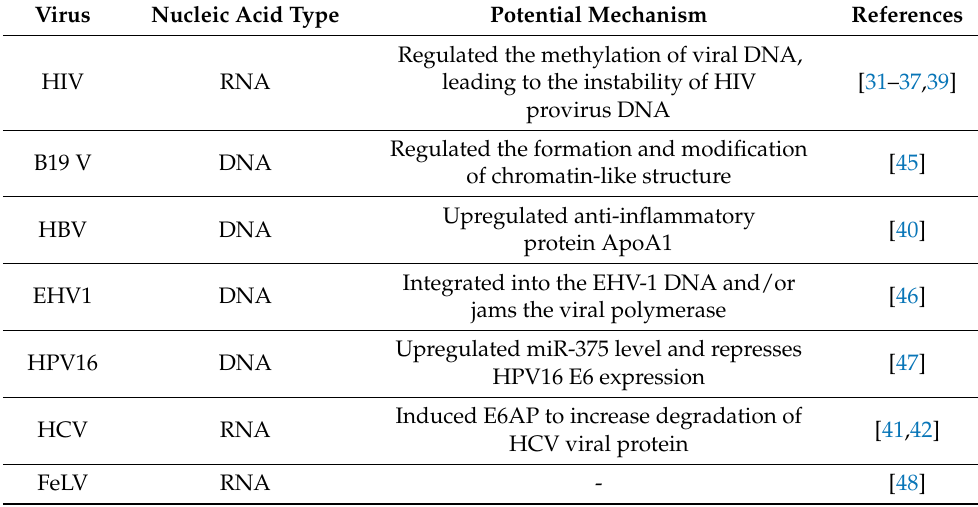
Table 1. Decitabine antiviral effects and potential